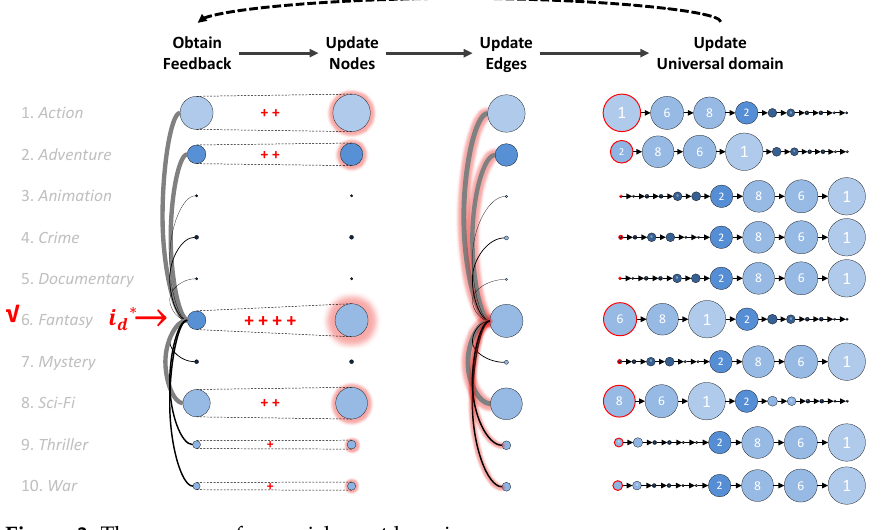
Figure 3. The process of re-enrichment learning. Table 1. The pseudocode for re-enrichment learning.